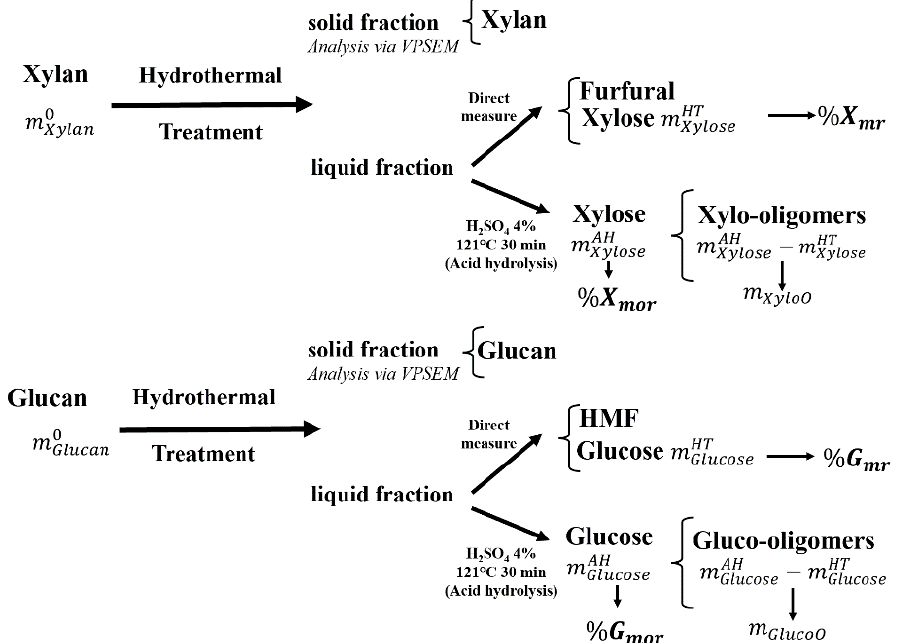
Figure 4. Xylan and glucan release pathways. %X mr and %G mr are the monomers released from xylan to xylose and from glucan to glucose, respectively, while %X mor and %G mor are the polymers released from xylan to both xylose and XOOs and from glucan to both glucose and GOOs, respectively.